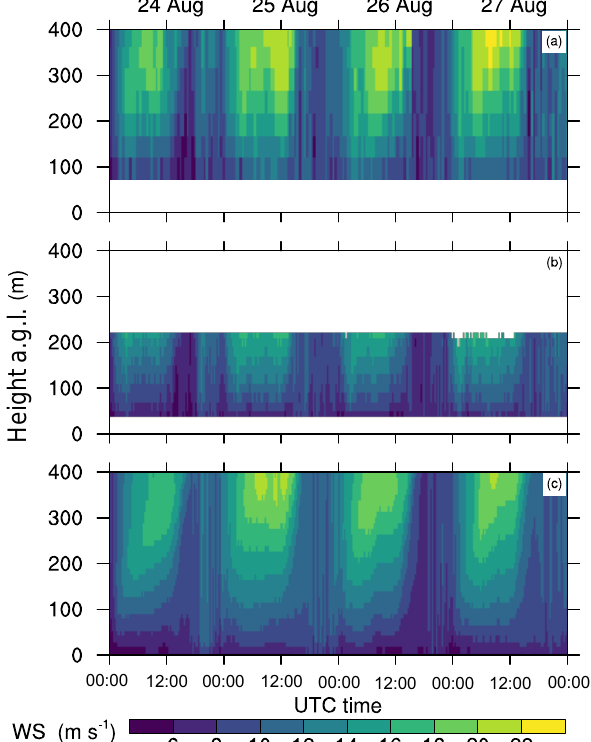
Figure 3. Time–height contour of WS from the 200S (a) , the WC (b) , and the ERA12 at the closest grid point to the 200S (c) .